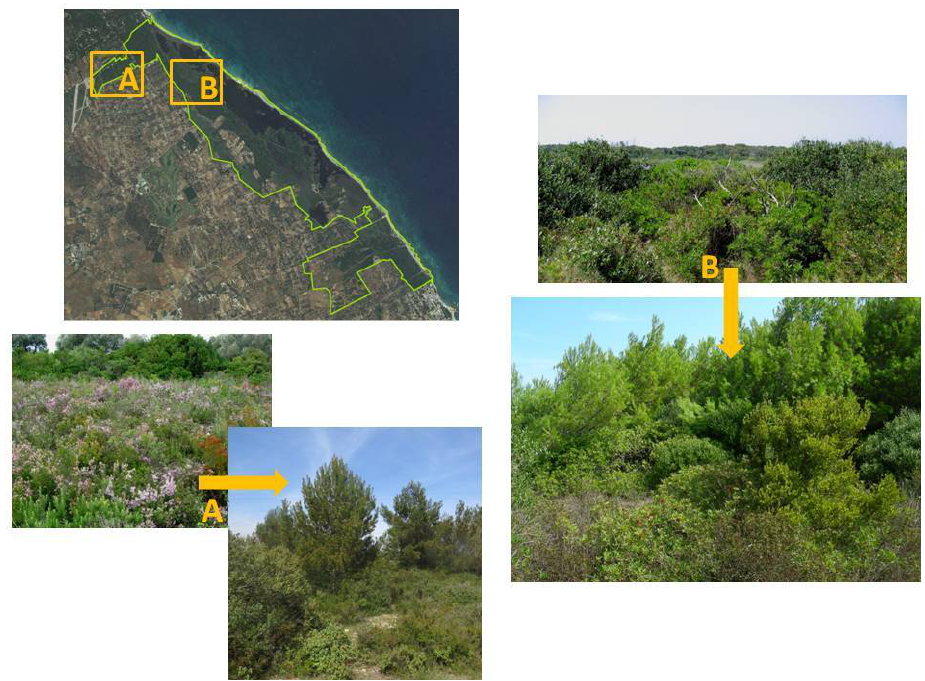
Figure 9. Localization of areas affected by pine encroachment in the Mediterranean garrigue ( A ) and maquis ( B ) in the CE site and photographic images depicting the ongoing process.